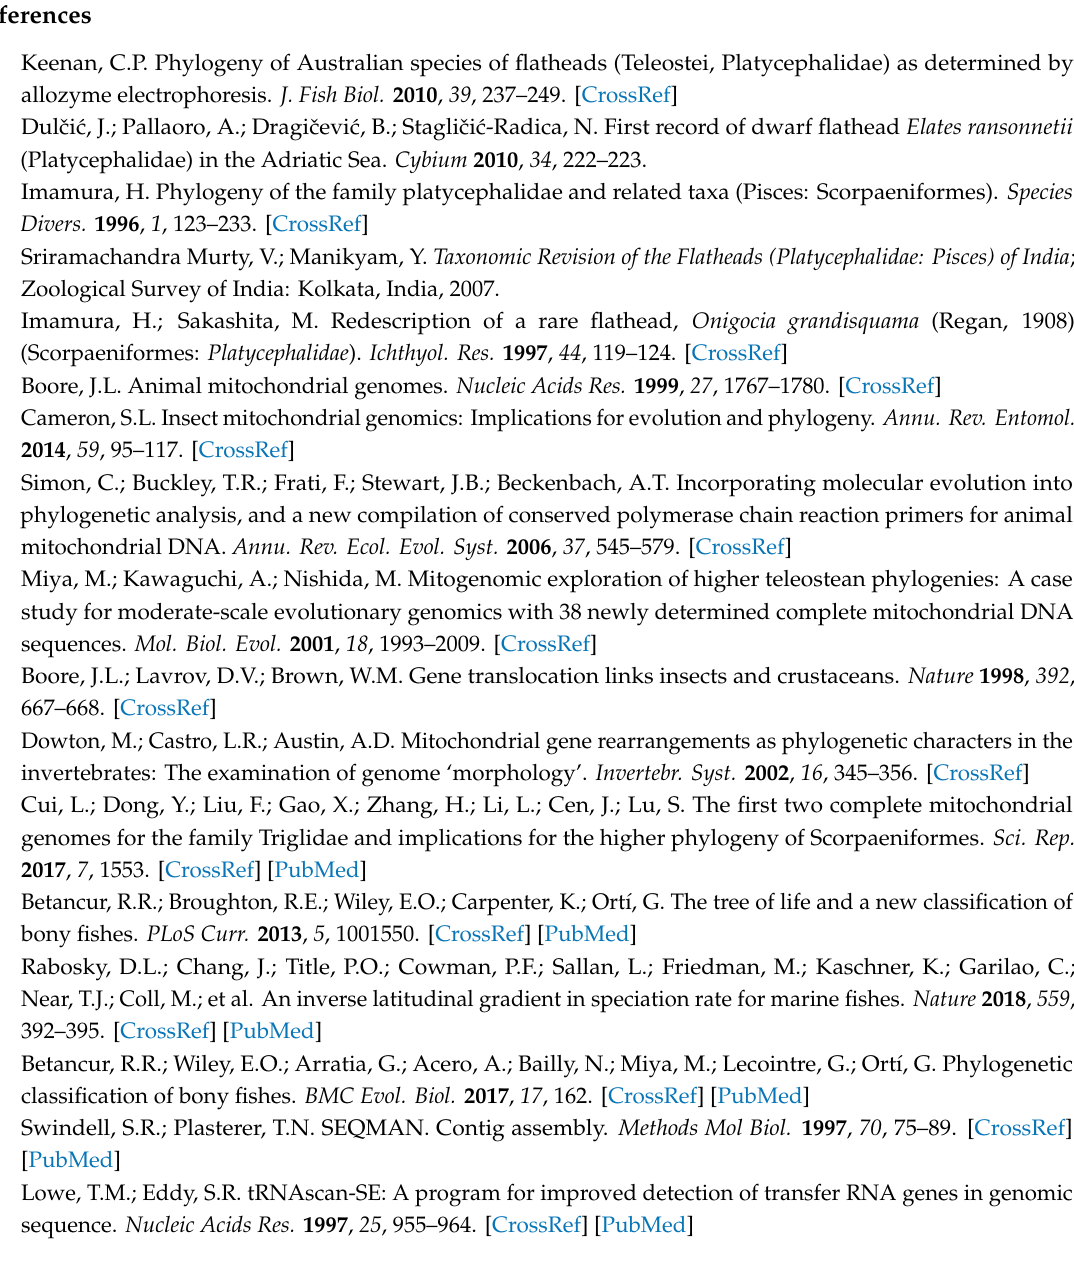
Figure S1: Organization of the complete mitochondrial genome of C. crocodilus , Figure S2: Predicted secondary structures of 22 tRNA genes in the C. crocodilus mitogenome. Figure S3: The putative secondary hairpin structural features of the O L in the mitogenome of C. crocodilus , Figure S4: The structure of the control region in the mitogenome of C. crocodilus , Table S1: Primer pairs used for PCR amplification of C. crocodilus mitogenome, Table S2: Codon number and RSCU in C. crocodilus mitochondrial